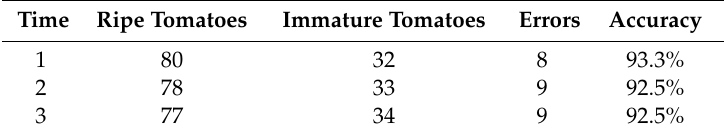
Table 3. Results of maturity